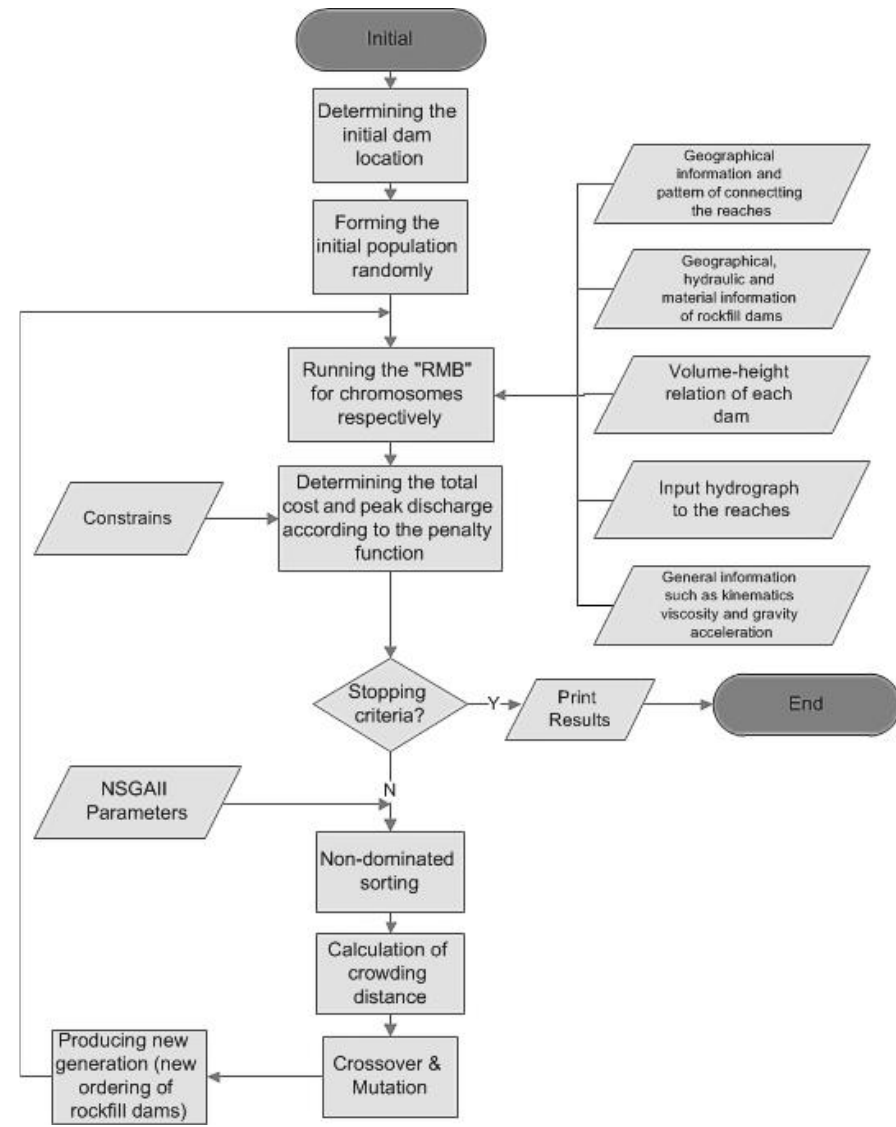
Figure 5 . Flowchart of the simulation-optimization model